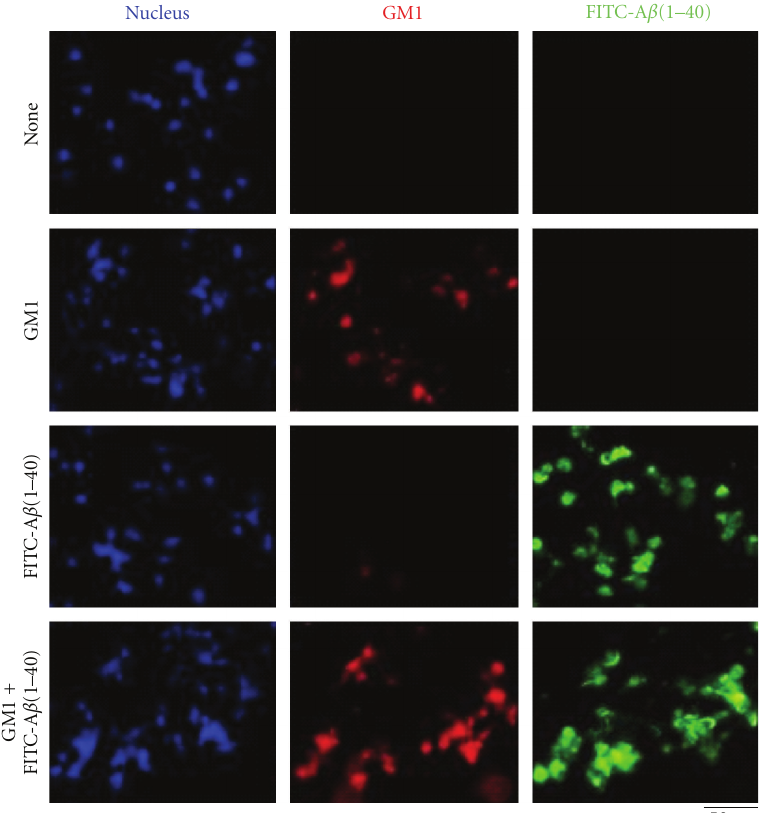
Figure 4: Incorporationof exogenously added GM1 and A β 1–40 into NECs. NECs were cultured in the presence ofGM1 (0 or 40 μ M) and/or fluorescein isothiocyanate-conjugated A β 1–40 (FITC-A β 1–40; 0 or 10 μ M) for 2 days, and then stained with biotin-conjugated CTXB, a probe to detect GM1, and rhodamine-conjugated streptavidin. Nuclei were stained with Hoechst 33258. (Reproduced from [114] with